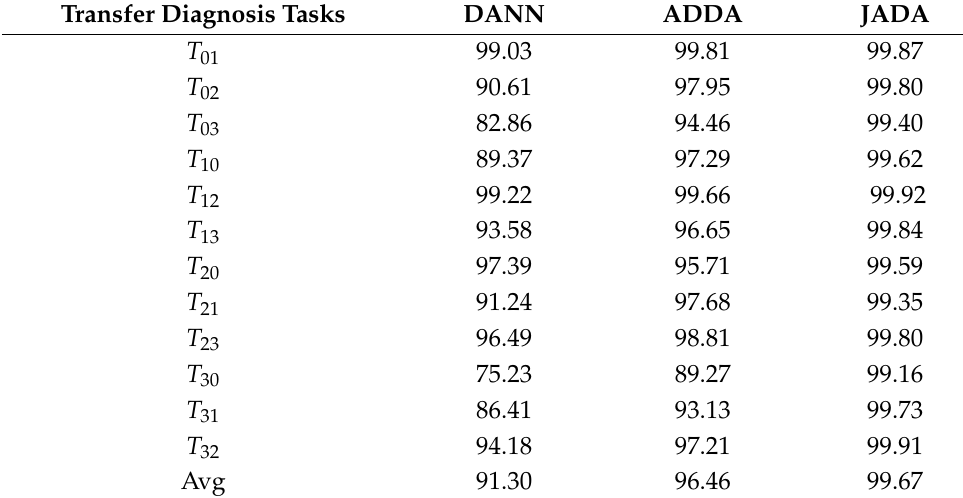
Table 6. Diagnosis results for the cross-domain bearing datasets (%).